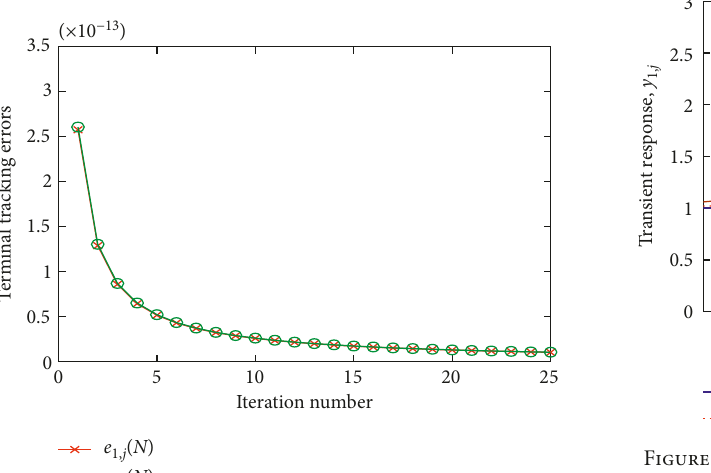
1 at the 20th, 50th, and 100th